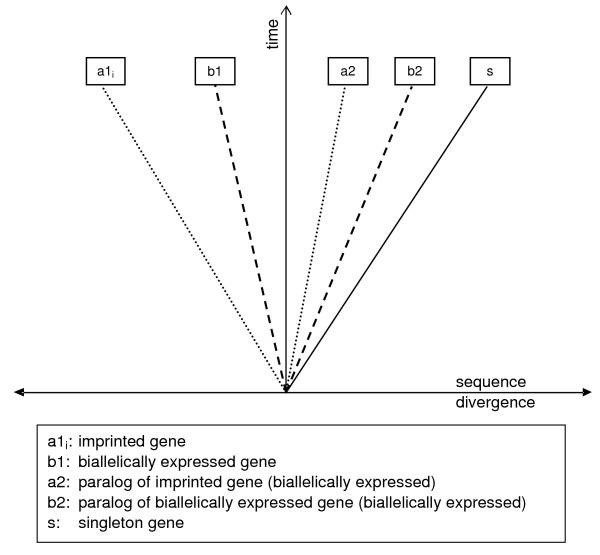
Complementary divergence. The orthologs of single copy genes (s) are more diverged than the orthologs of genes that possess paralogs. Regarding paralogous pairs of biallelically expressed genes (b1, b2), one is usually more diverged than the other. If an imprinted gene (a1i) has a paralog (a2), the imprinted gene itself is in most cases the more divergent one.